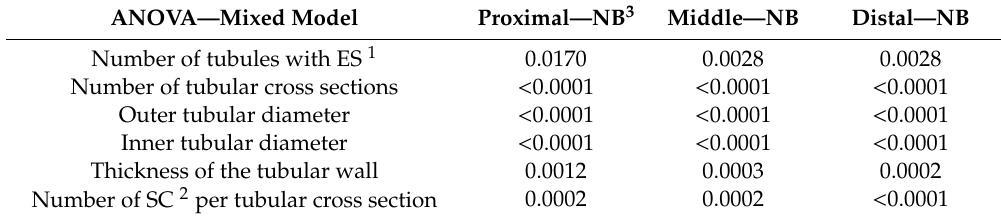
Table 4. Test results (i.e., p-values) of the ANOVA (mixed model) comparing the three di ff erent locations in en bloc samples (n = 192) with the needle biopsy (n = 32) measured in HE staining. In order to account for the multiple testing situation, P-values were compared to the Bonferroni-adjusted significance level of alpha Bonf = 0.05 / 6 = 0.0083.